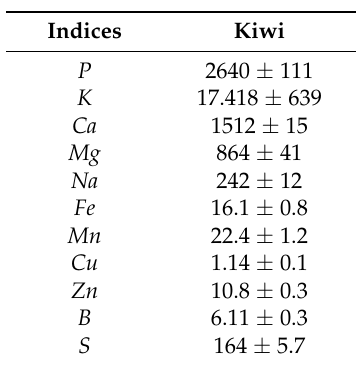
Table 1. Mineral content of kiwi fruits organic (mg/kg)